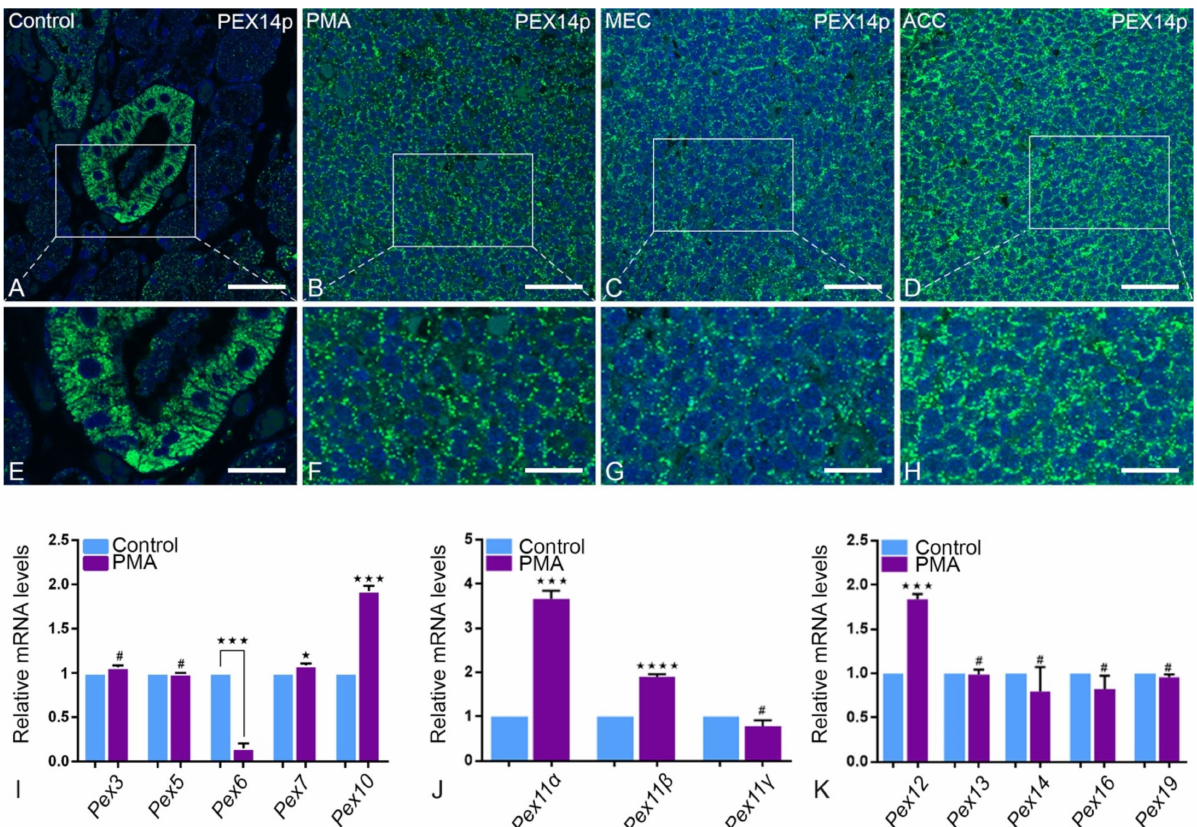
Figure 3. Peroxisomal biogenesis proteins and mRNAs in PMA, MEC and ACC: Control parotid gland PEX14p staining ( A ) is evenly distributed among the acinar cells. The striated duct cells in the magnification ( E ) show a high expression of PEX14p. In comparison PMA ( B ), MEC ( C ) and their respective magnifications ( F , G ) show a lower reaction level than the duct cells and the acinar cells in relation to the cell number. In ACC ( D , H ), a higher abundance of PEX14p can be detected compared to the two other tumor types. This is confirmed by the mRNA expression of Pex14 in PMA ( K ). Some Pex genes are expressed lower in PMA than in the control group, such as Pex6 (*** p = 0.0001) in ( I ), Pex11 γ in ( J ), as well as Pex16 and Pex19 in ( K ). Only in the first case is the down regulation significant. In contrast, Pex7 (* p 0.0178) and Pex10 (*** p = 0.0001) in ( I ), Pex11 α (*** p = 0.0001) and β (**** p < 0.0001) in ( J ) and Pex12 (*** p = 0.0002) in ( K ) are significantly upregulated. Bars represent 50 µ m: ( A – D ); 18 µ m: ( E – H ). (Explanation of the notations: The number of asterices signifies the degree of significance of the p -value, while # means not